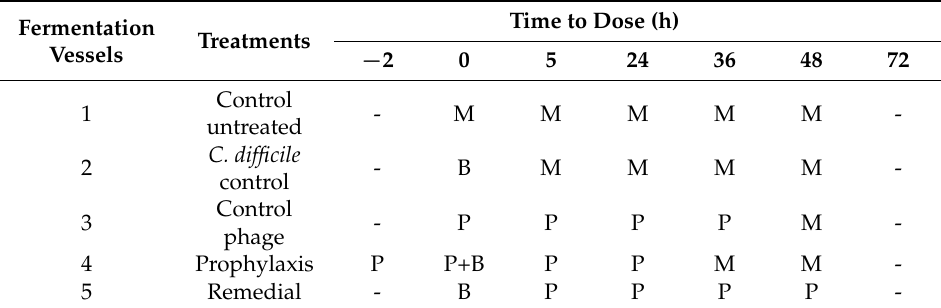
Table 1. Bacteria and phage treatment regimens for the gut fermentation